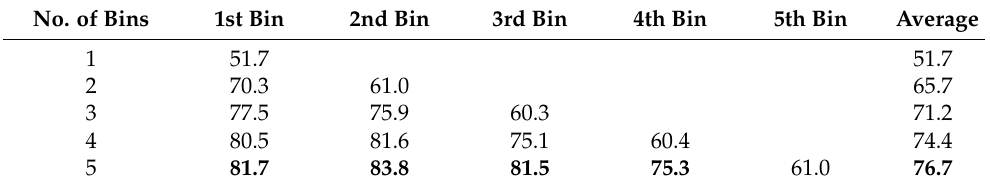
Table 7. The average percentage filled (%) of each bin in case of multibin